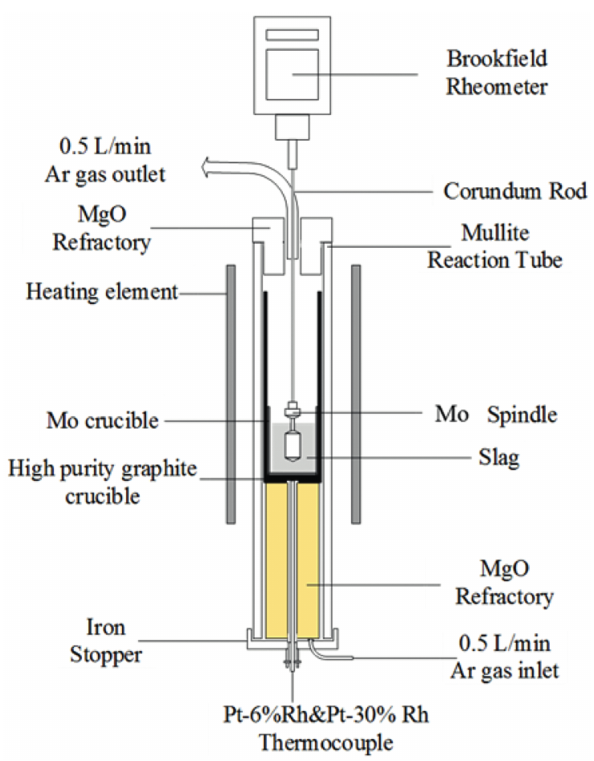
Figure 3: Experimental apparatus for the slag viscosities